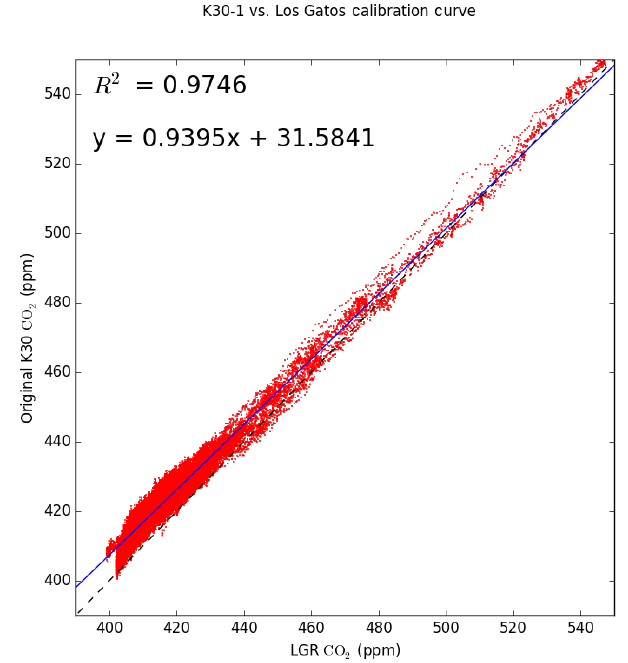
Figure 5. Calibration curve of K30-1 vs. LGR for 1min averages without any environmental correction, only span and zero offset are corrected. Solid line is the best fit; dashes represent the 1 : 1